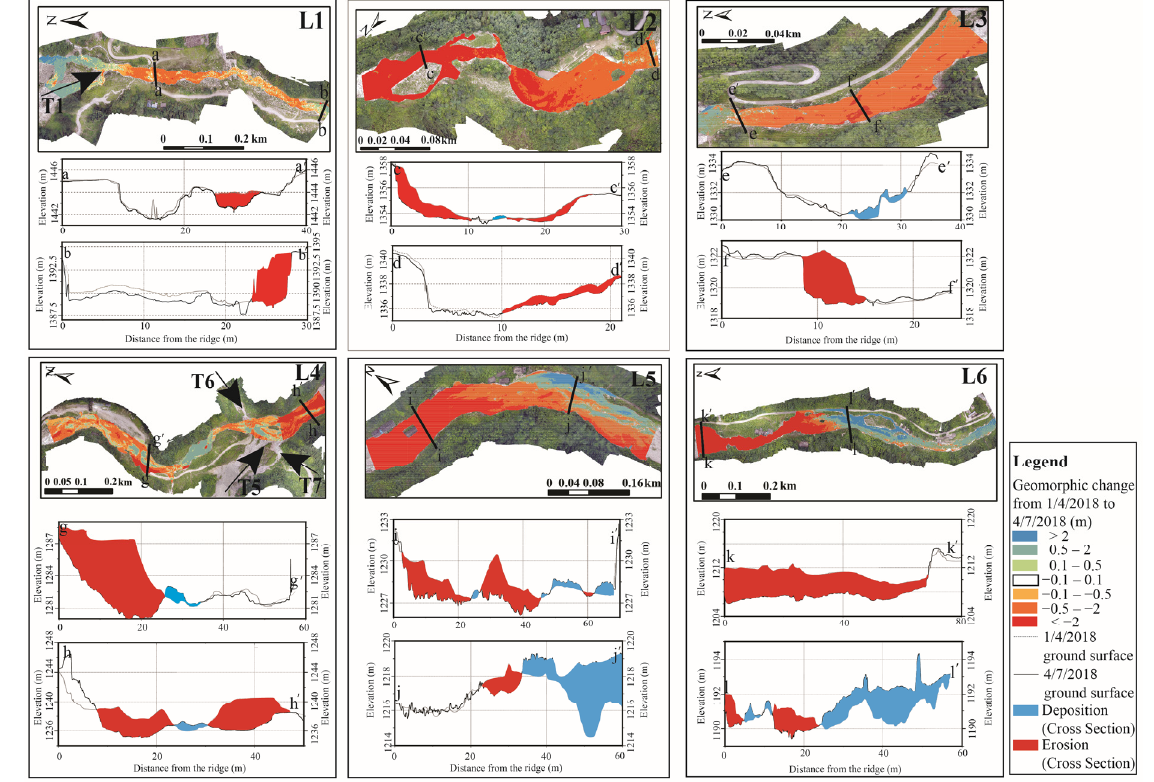
Figure 5. Changes of the channel after this flash flood. L1 – L6 represent the geomorphic changes of overall channel parts and cross sections in different parts from upstream to downstream in the study area. Among them, L1 represents the most upstream part and L6 represents the most downstream part. a – a ’ to l – l ’ represent the cross sections in different parts. T1, T5 – T7 represent the tributaries along the study area. Table 2. Characteristics of channel changes in the different parts of the channel.